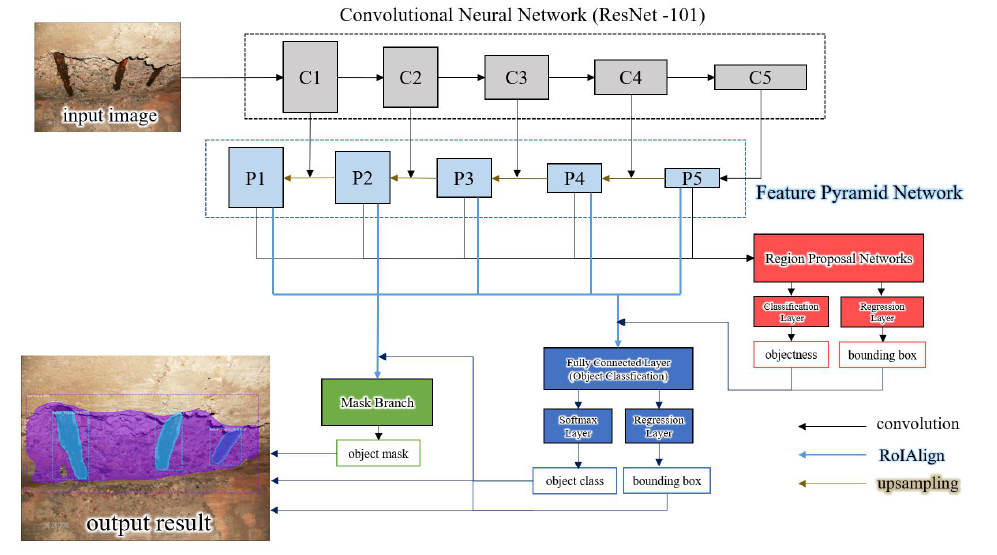
Figure 1. Overall architecture of Mask